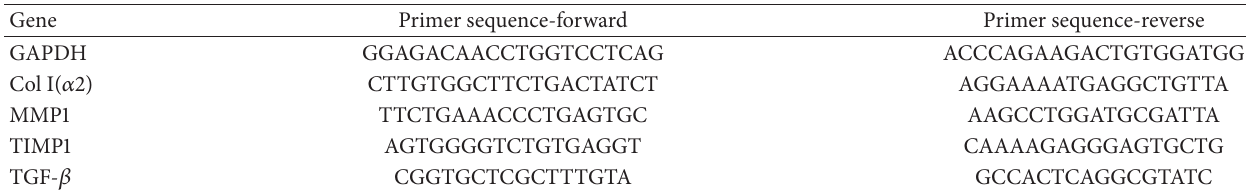
Table 1: Primers for